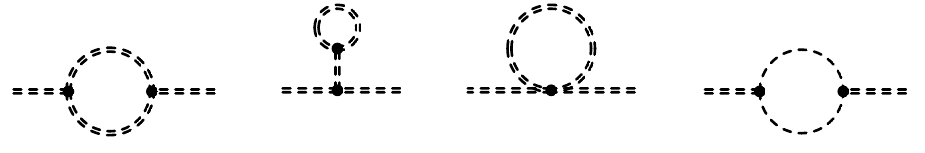
Figure 6 . One-loop contributions to the propagator of the real singlet scalar. In the MS scheme the UV poles of the (cid:12)rst and second diagram cancel against each other. The line styles and their meanings are identical to those employed in (cid:12)gure